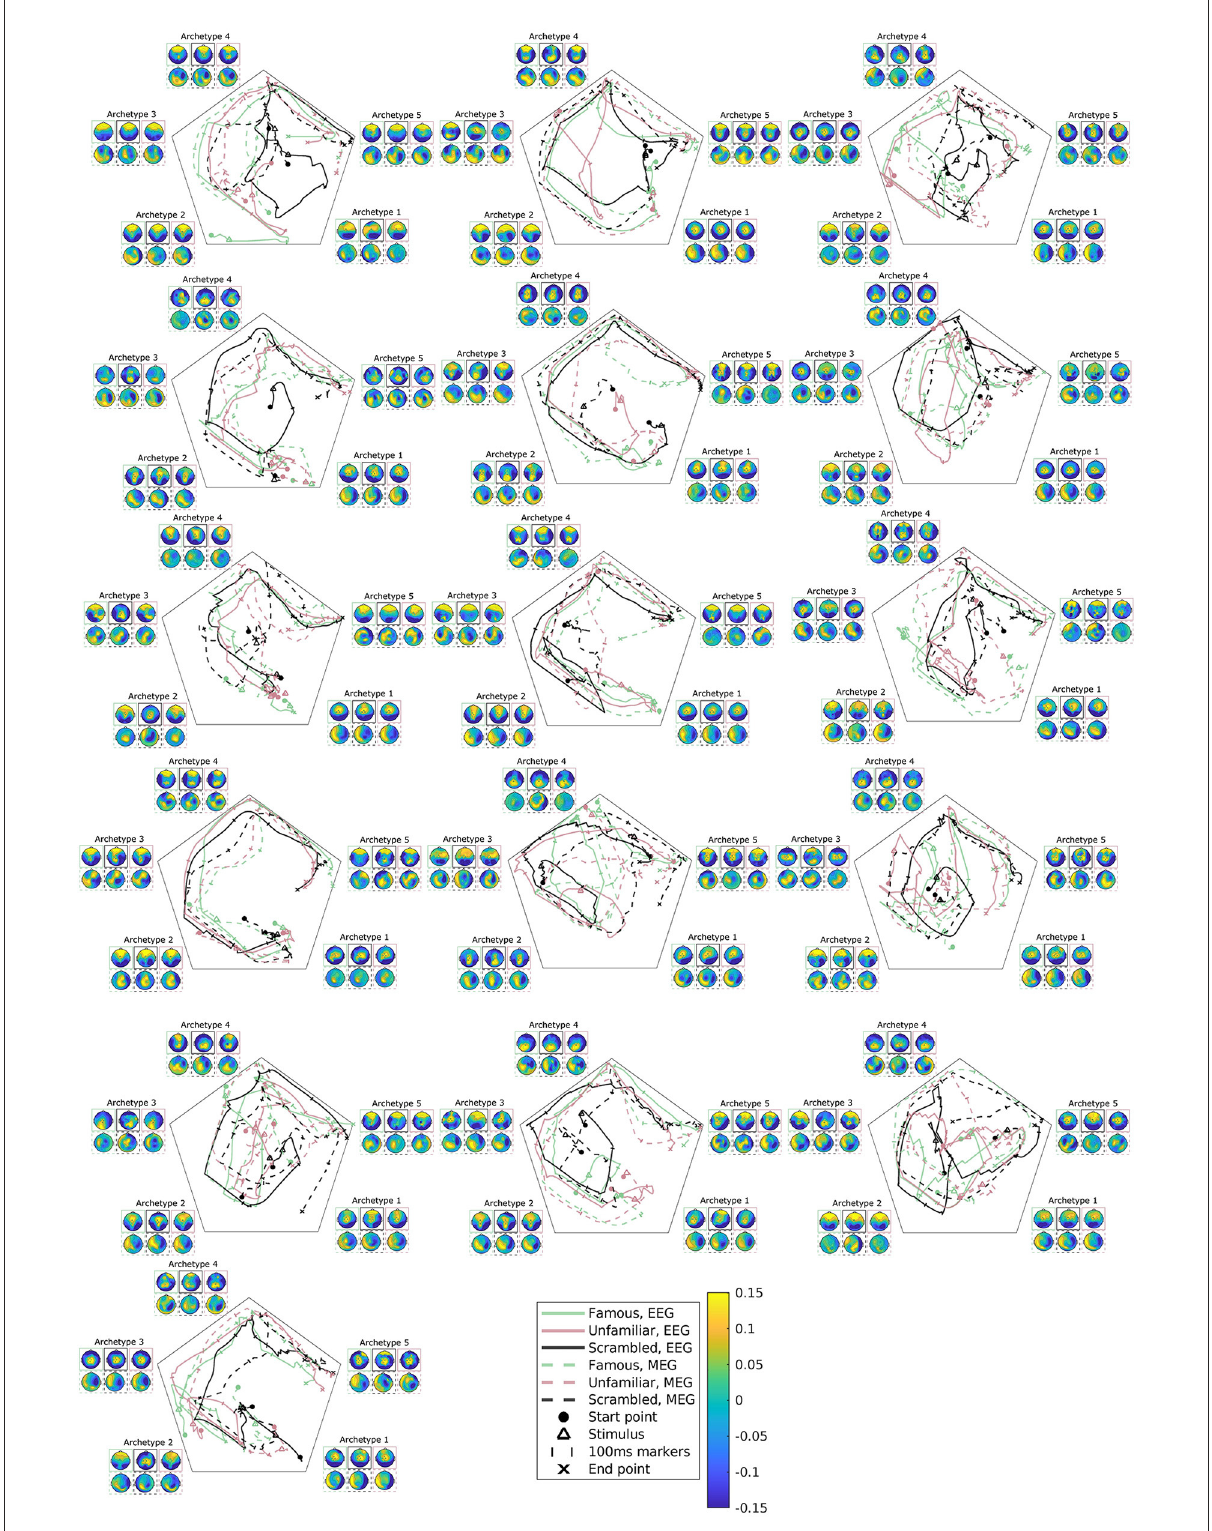
FIGURE7 Subject, modality, and condition-specific archetypal trajectories and archetypes for the best multimodal, multisubject DAA model in terms of loss with K 5 components. The matrix S has been smoothed with a rectangular window of size 30 samples for visualization purposes. The = figures are ordered by subjects, arranged from left to